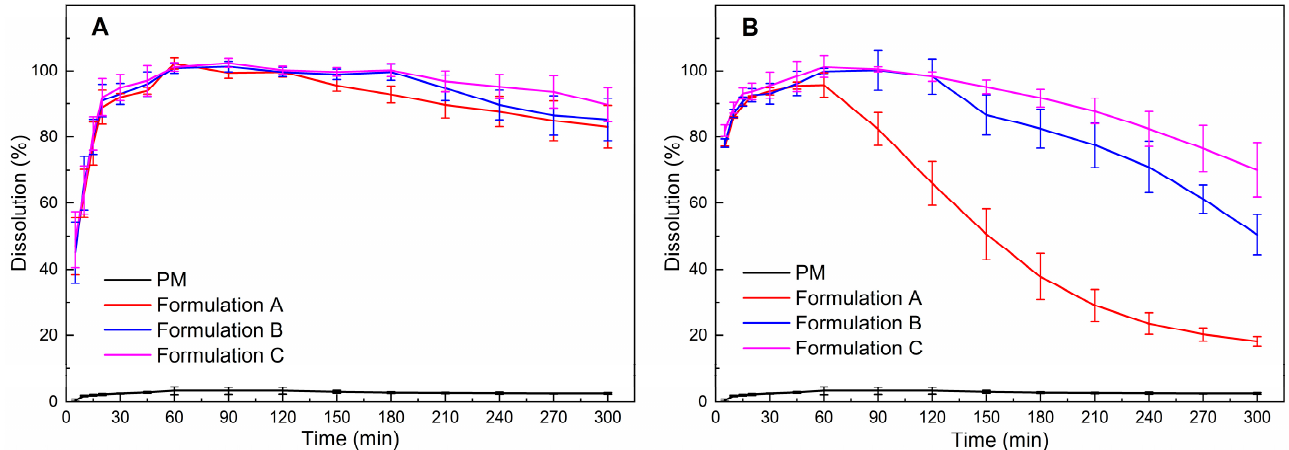
Figure 3. The dissolution of physical mixture of ritonavir/PVPVA/Span 20 (PM), extrudates ( A ), and milled extrudates ( B ). (mean ± S.D., n = 3.).